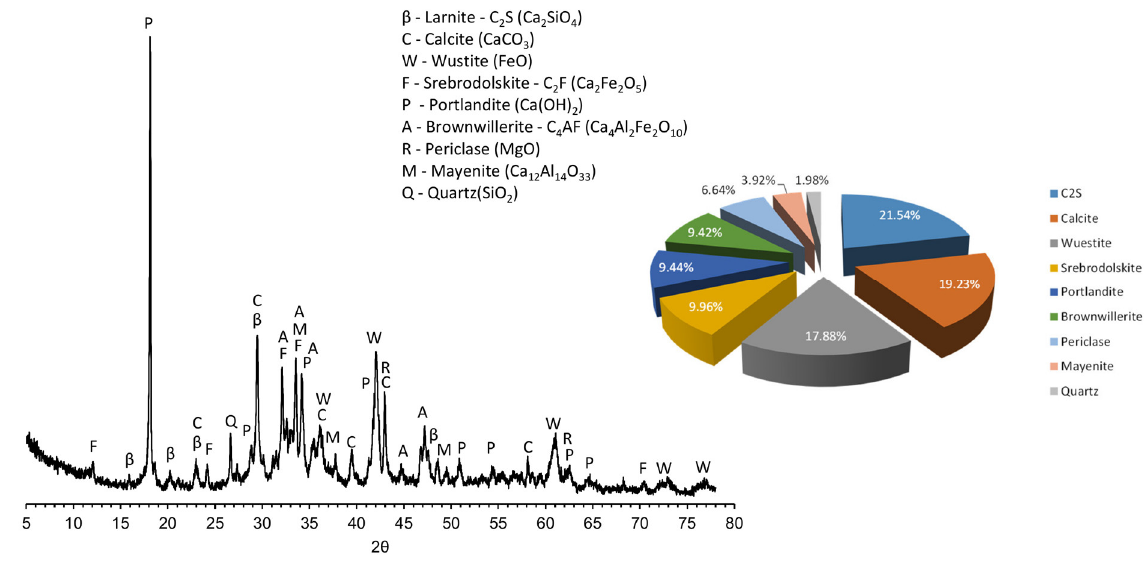
Figure 2. XRD pattern and Rietveld refinement.